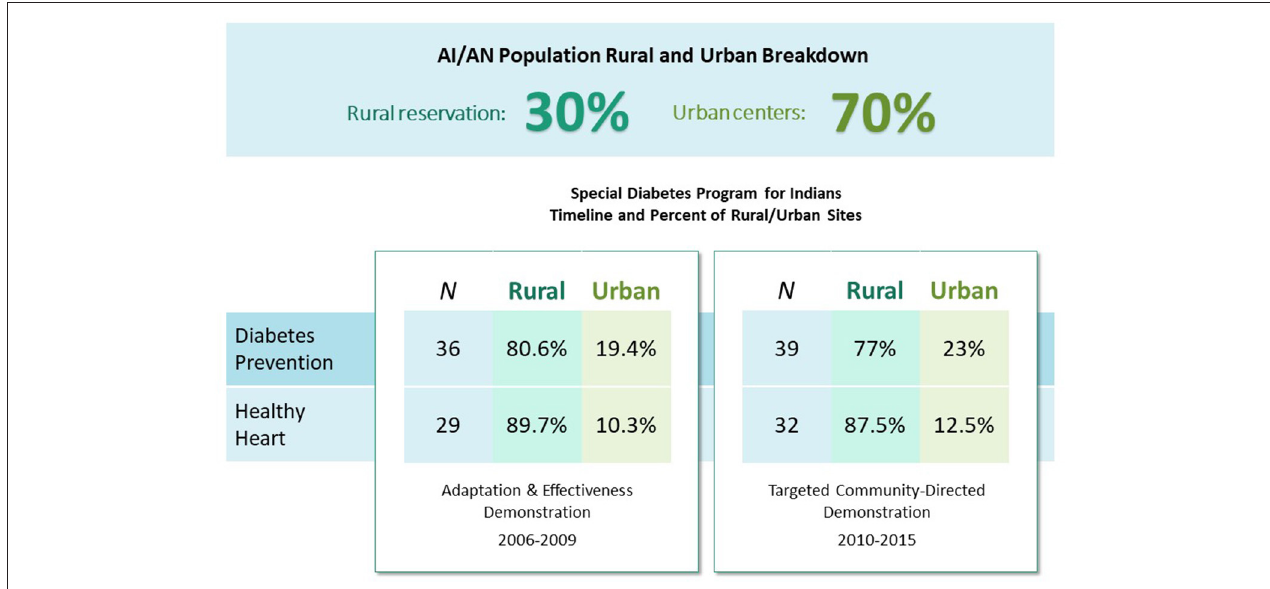
FIGURE 1 | Rural and urban diabetes demonstration program implementing sites: timeline and AI/AN population